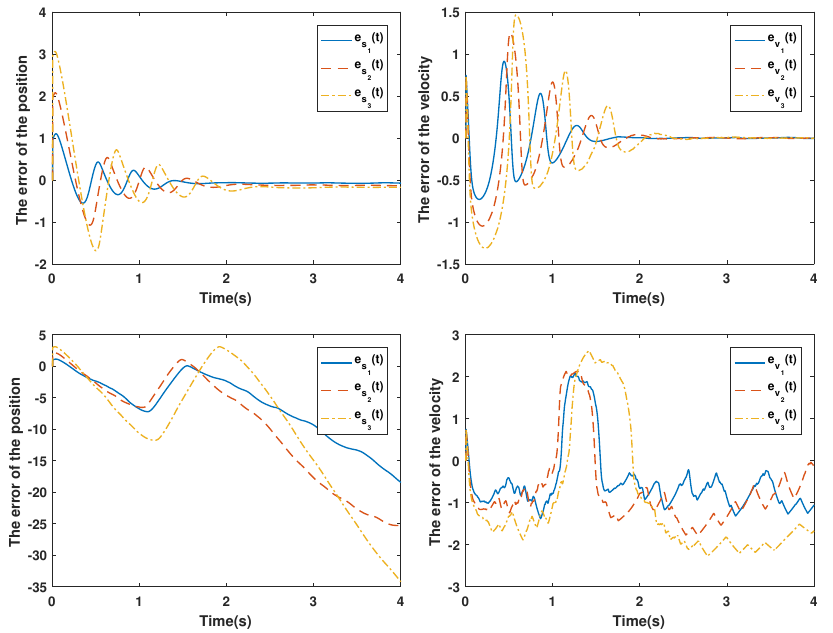
Figure 5. The errors of the position and velocity for the vehicular platoon system between the proposed method ( up ) and the method in [13] ( down